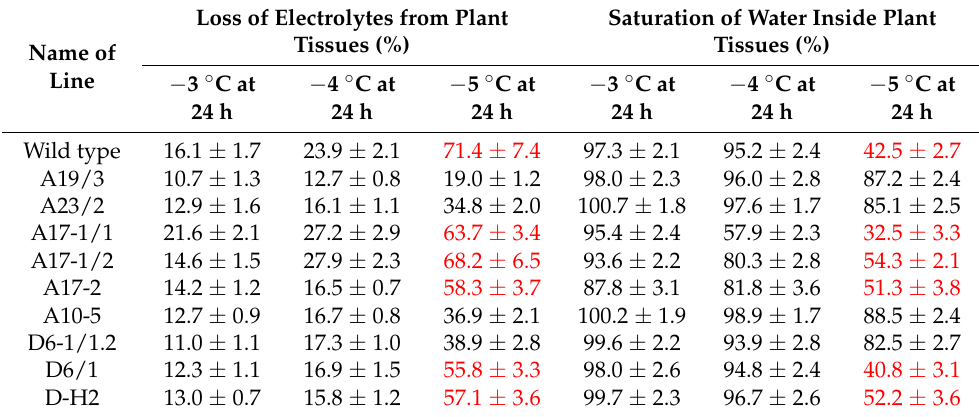
Table 1. Loss of electrolytes from leaves of non-hardened transgenic plants and non-transgenic plants on the first day after 24 h exposure at negative temperatures and water content in the same plants a week after exposure at negative tempera- tures relative to plants without freezing * .